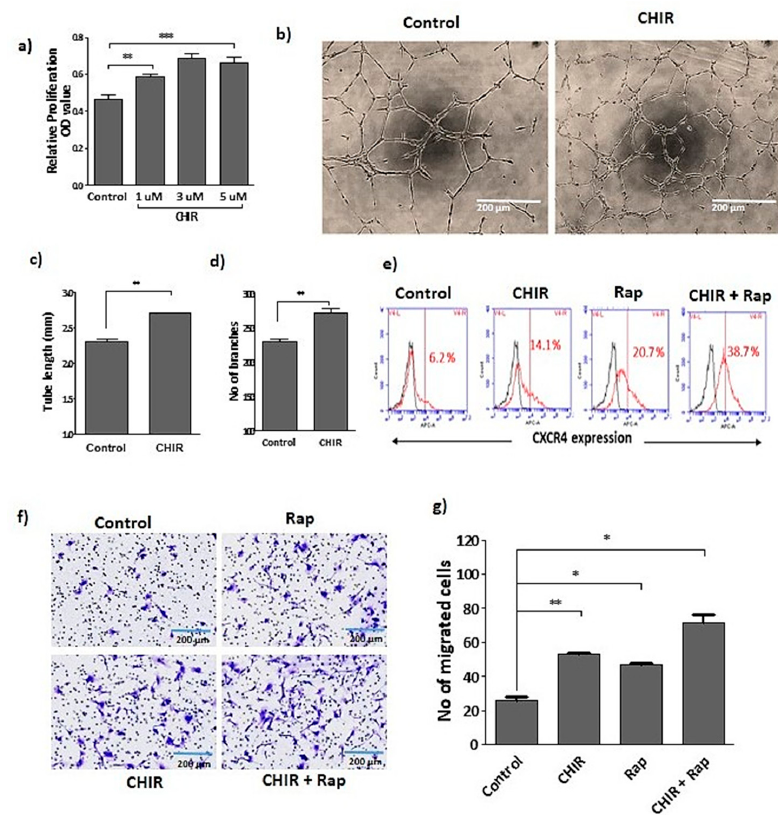
Figure 1. Stimulation of CHIR99021 established the late EPCs functional activity. ( a ) Cells were treated with CHIR99021 at different doses (1, 3, 5 uM) for 24 h, and proliferation was assessed by using wst-1. ( b ) Growth factor reduced Matrigel used for tube formation assay. The vessel structure was visualized using a light microscopy. Tube length and branches were quantified using ImageJ. ( c , d ) Quantification of total tube length and number of branches. ( e ) The treatment with CHIR99021 (3 uM) alone or co-treated with rapamycin (20 nM) for 24 h in late EPCs. Fluorescence activated cell sorting was performed by using non-stained cells as a negative control. The fraction of positively stained cells was determined by comparison with non-stained cells. The fraction of positively stained cells is indicated by the positive peaks (red lines indicate cells stained with each antibody, and black lines indicate the negative control). ( f ) Transwell migration assay was performed by seeding cells in the upper inserts of the transwell chambers, whereas medium containing the drug was loaded into lower chambers of the plate. The cells were incubated for up to 6 h, and the number of migrated cells was counted in three random fields for each membrane filter (20× magnification) under microscope. ( g ) Quantification of migrated cells. Data are presented as mean ± standard error of the mean (SEM). The results are considered statistically significant at * p < 0.05; ** p < 0.01; *** p < 0.001 when compared to untreated groups. (Rap-Rapamycin).